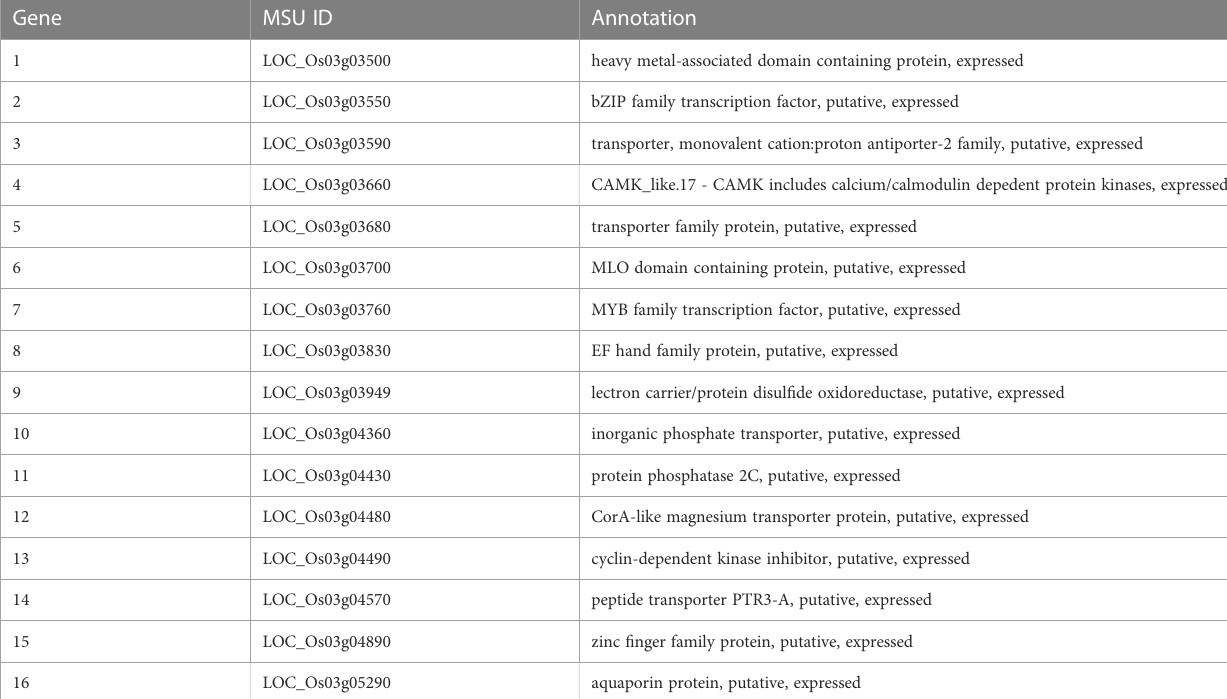
TABLE 3 Annotations of the selected candidate genes for qSMg3 and qTrMg3 .